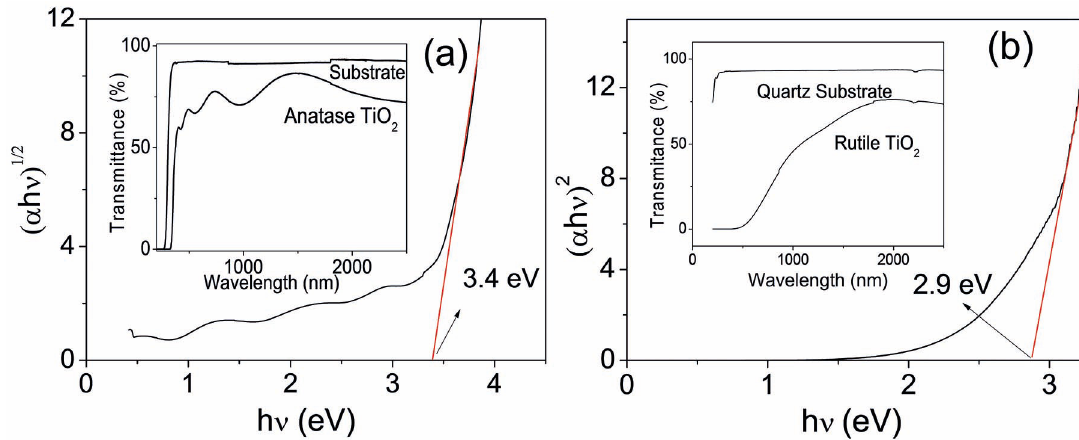
thin film, obtained from absorbance data. Anatase has indirect transition. Figure 5. (a) Evaluation of bandgap for anatase structure of TiO 2 Inset: Transmittance spectra for TiO thin film deposited on soda-lime glass substrate. (b) Evaluation of bandgap for rutile structure of 2 TiO thin film. Rutile has direct transition. Inset: Transmittance for TiO thin film deposited on quartz 2 2